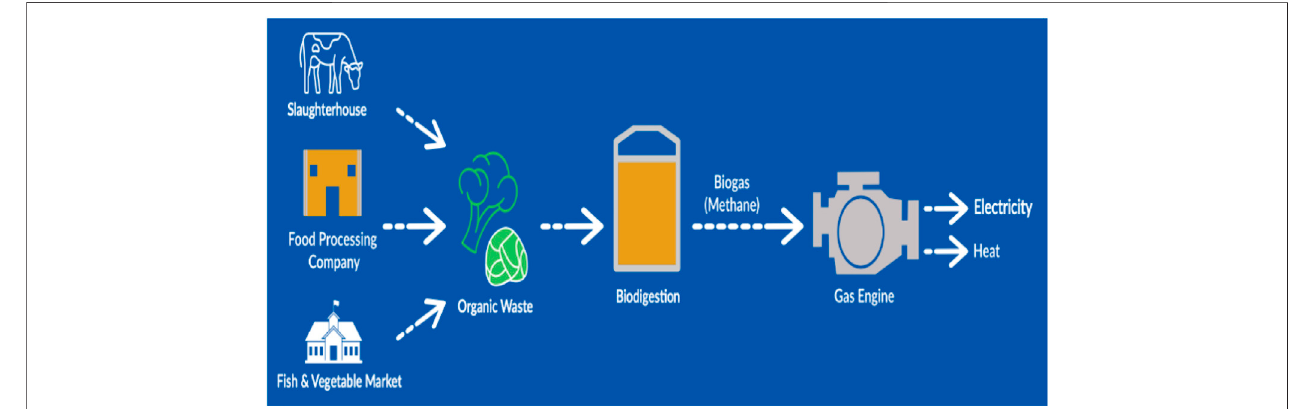
FIGURE 10 | Organic waste diversion in